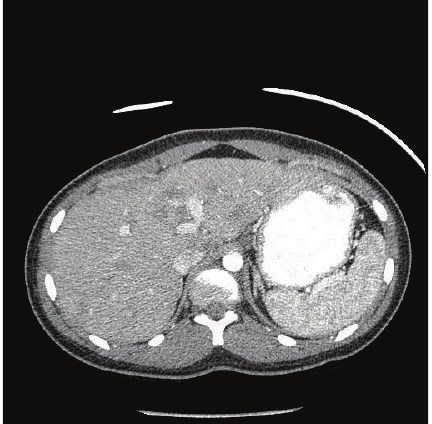
Figure 1: Abdominal CT showing multiple poorly defined low attenuation lesions.